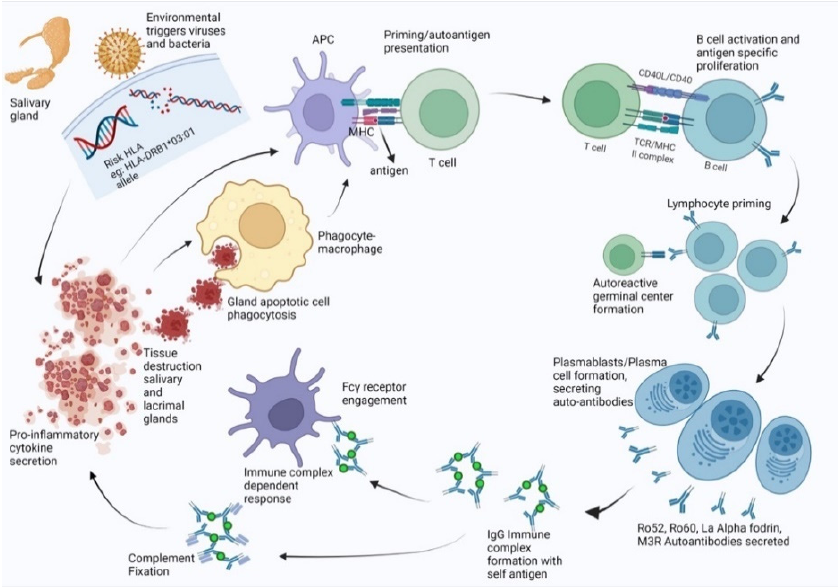
Figure 6. Disease progression for individuals with genetic predisposition (specific HLA) and micro- bial trigger.